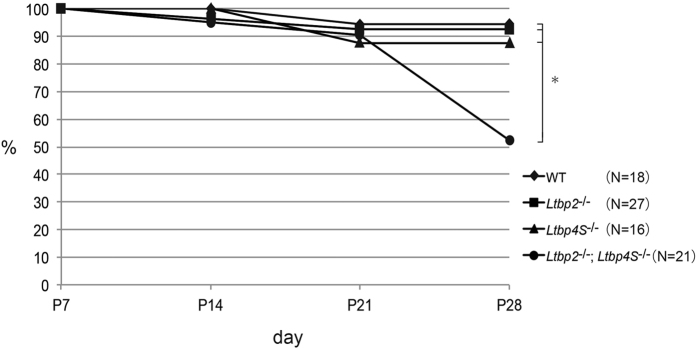
Survival rate of Ltbp2/4S mutant mice after birth.Starting from postnatal day 7 (P7), pups of wild type, Ltbp4S−/− mice (produced by intercross of Ltbp4S+/− mice), Ltbp2−/− mice, and Ltbp2−/−; Ltbp4S−/− mice (produced by intercross of Ltbp2−/− and Ltbp4S+/− mice) were evaluated for survival every week. *P < 0.05, determined by log-rank test.